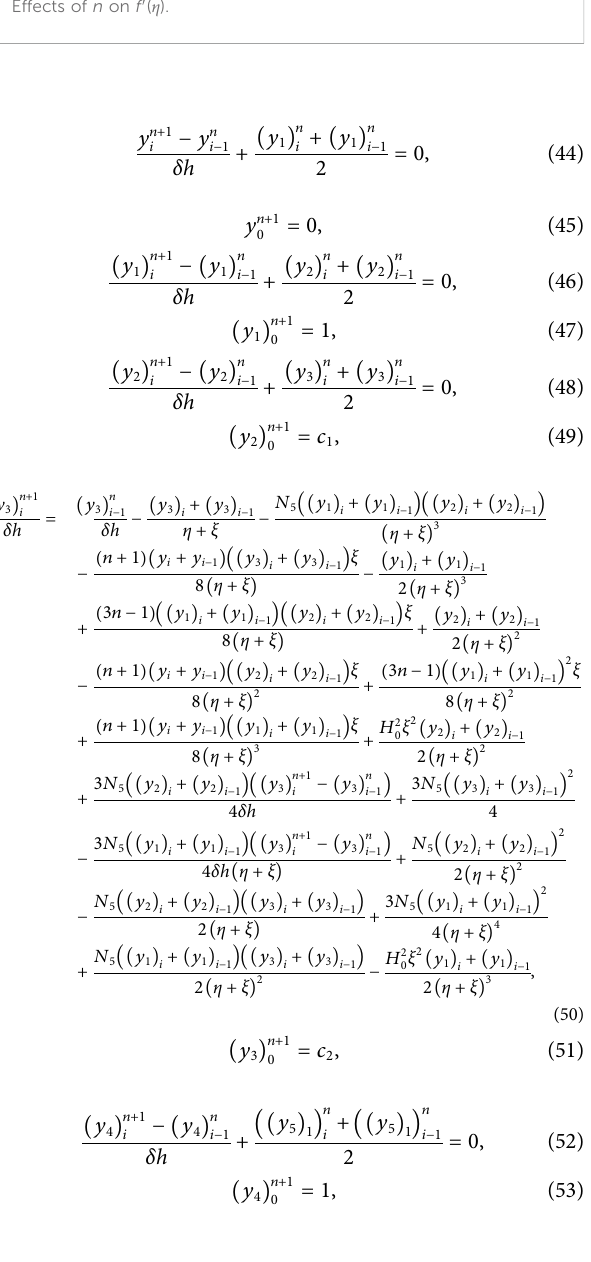
FIGURE 11 Effects of n on f ′ ( η ).